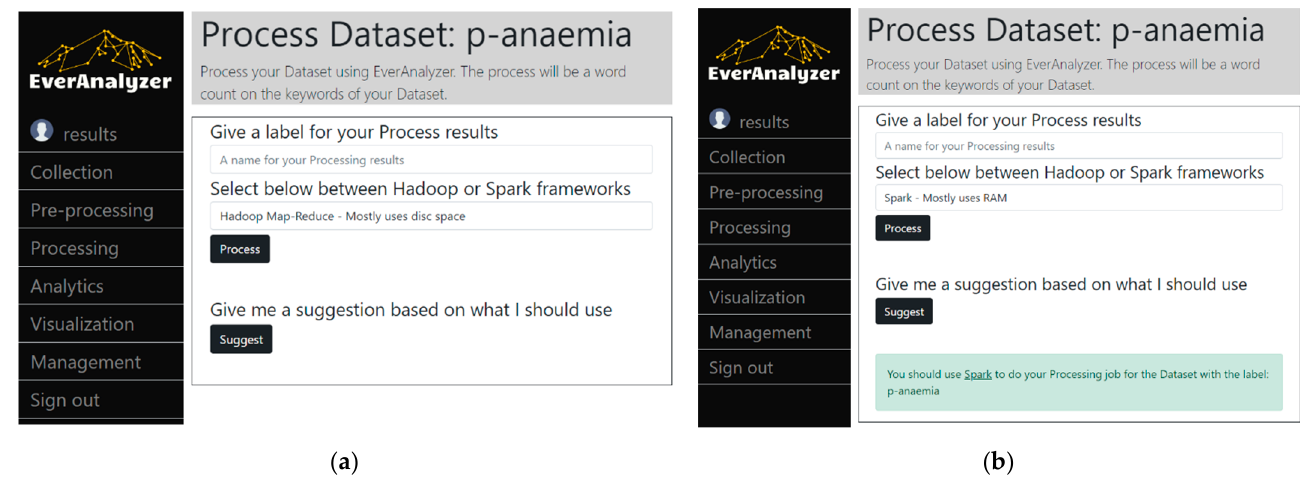
Figure 18. ( a ) Processing form; ( b ) Processing proposal.